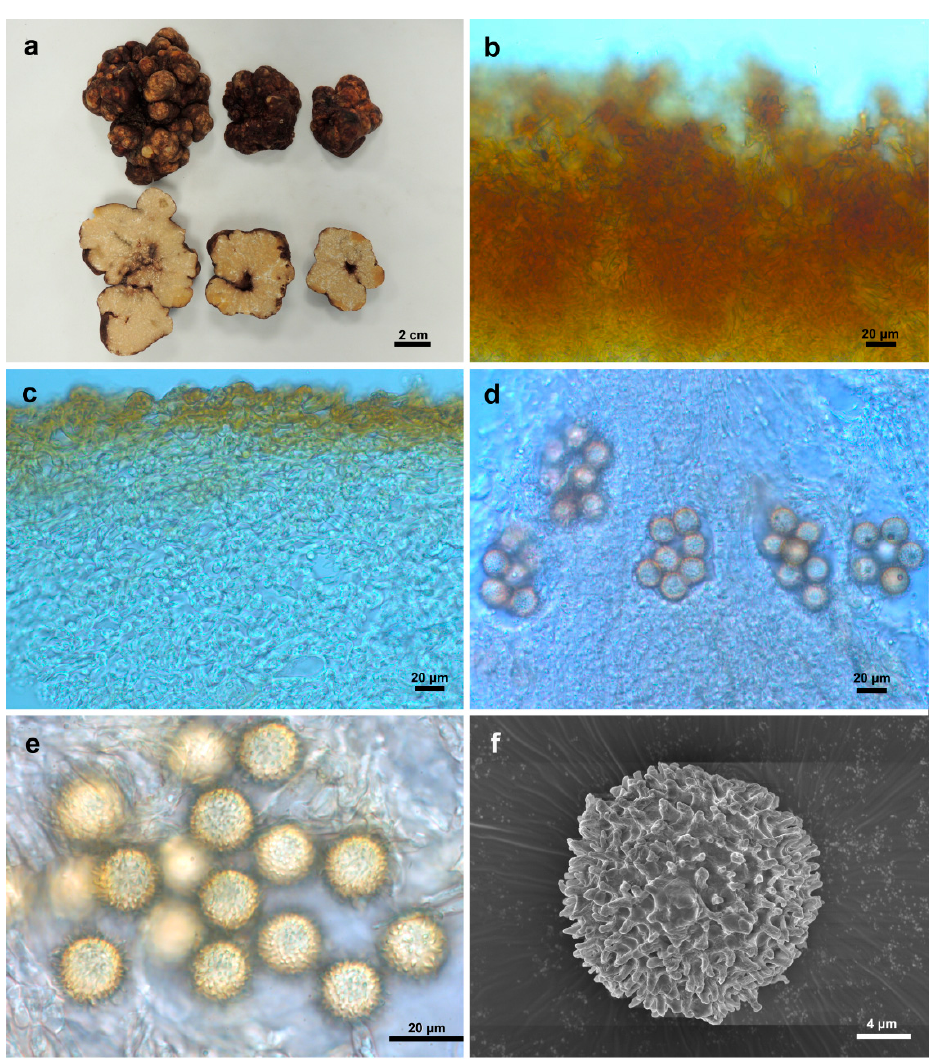
Figure 1. Choiromyces sichuanensis (YNAU003, Type): ( a ) ascoma; ( b ) dermatocystidia; ( c ) peridium section; ( d , e ) light micrograph (LM) of ascospores; ( f ) SEM image of an ascospore.